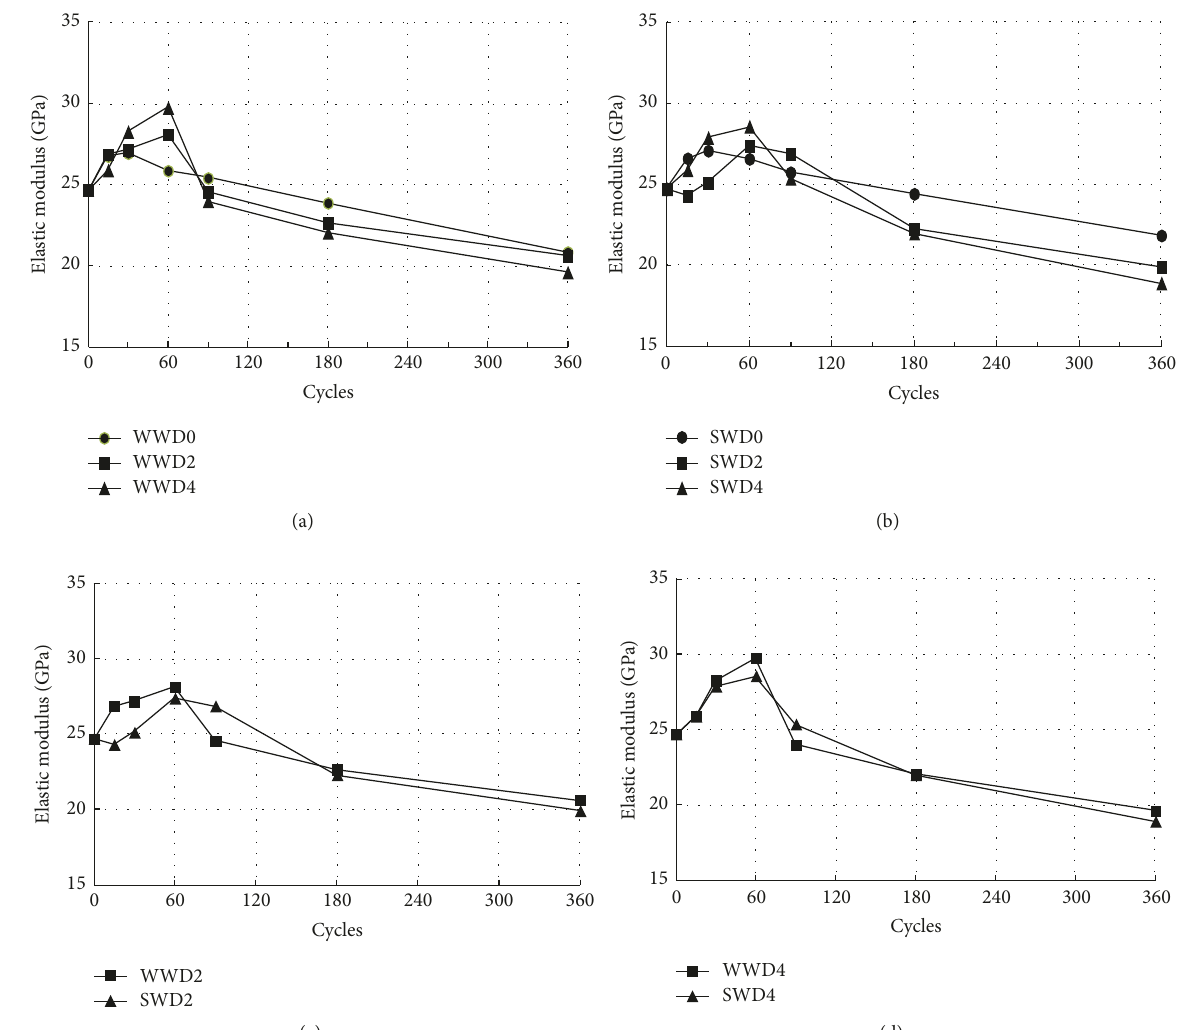
Figure 7: Elastic modulus of stressed specimens (a) subjected to WD cycles of distilled water and different loads; (b) subjected to WD cycles of saltwater and different loads; (c) subjected to WD cycles and 20% ultimate tensile strength; (d) subjected to WD cycles and 40% ultimate tensile